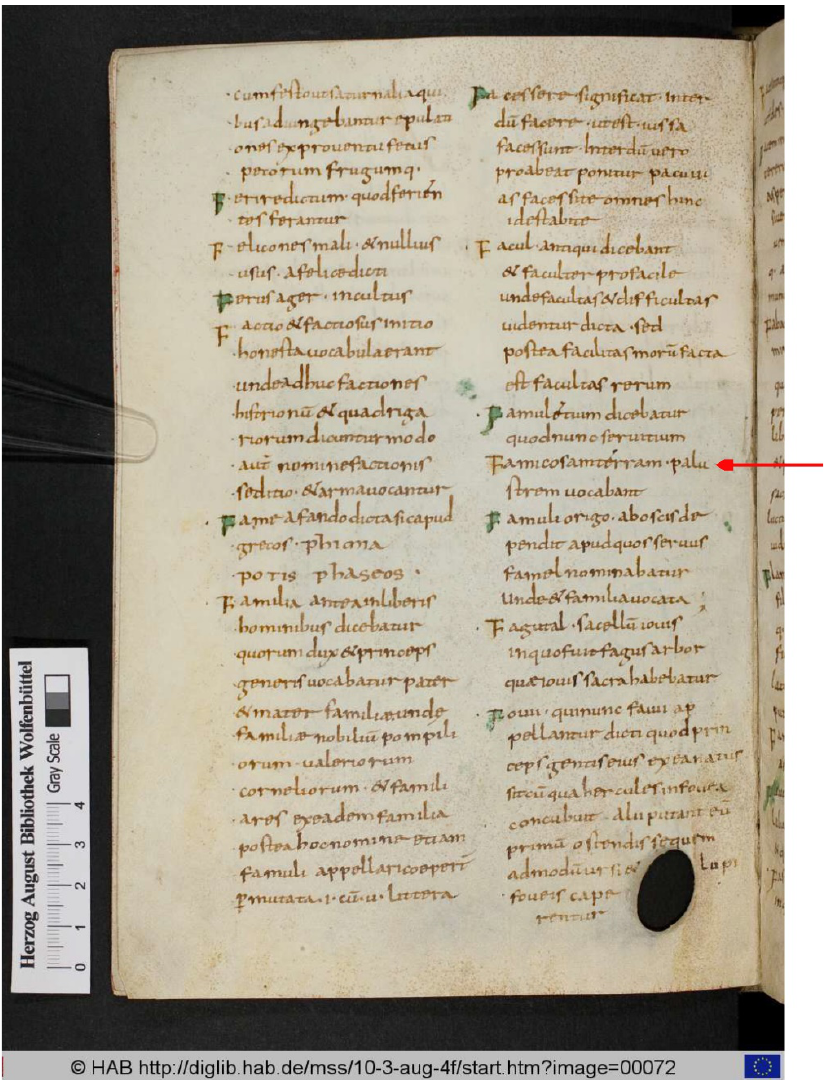
Figure 2. The “famicosus” entry in the 10 th century manuscript Cod. Guelf. 10.3 Aug. 4°; Heinemann-Nr. 2997, Herzog August Bibliothek Wolfenbüttel, http://diglib.hab.de/mss/10-3-aug-4f/start.htm?image= 00072, accessed 15 Jun